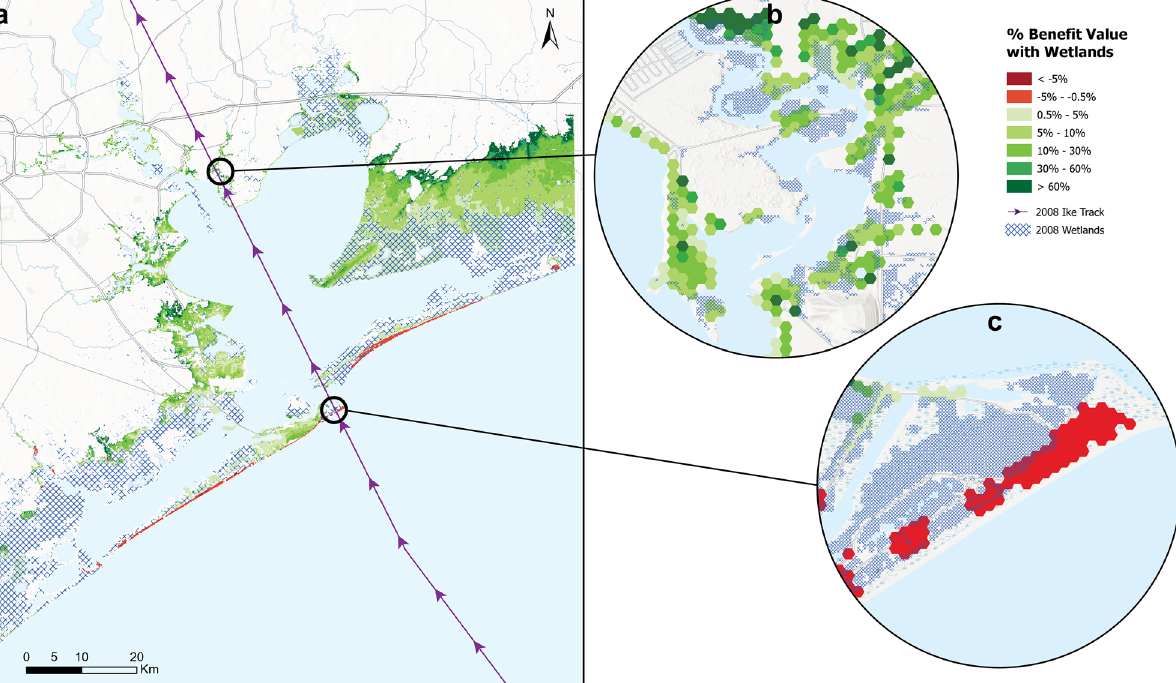
Figure 2. ( a ) Map shows the percentage benefit value of wetlands cover from 2008, calculated as the ratio of the difference in damages: (2008 No wetlands-2008 Baseline)*100/2008 Baseline. Inset panels ( b ) and ( c ) show detailed examples ofpositive and negative percentage benefit values, respectively, along H. Ike’s track for Houston Metropolitan and Galveston Island